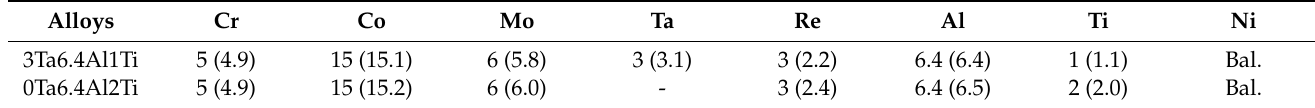
Table 1. The nominal and measured compositions (wt.%) of Ni-based SX superalloys. The measured compositions are listed in parentheses. The alloys are named by the concentration of Ta, Al, and Ti. For example, if the alloy contains 3 wt.% Ta, 6.4 wt.% Al, and 1 wt.% Ti, the alloy is called 3Ta6.4Al1Ti alloy for